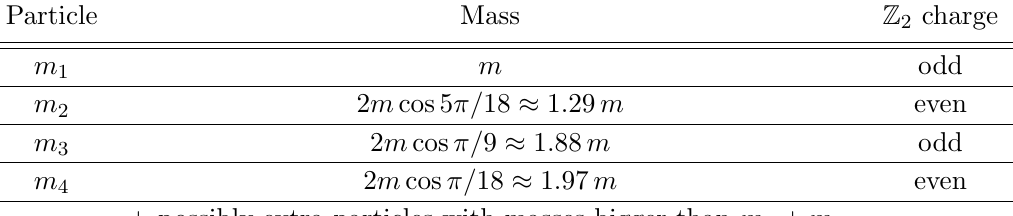
Table 1. Spectrum assumed for the analysis in this